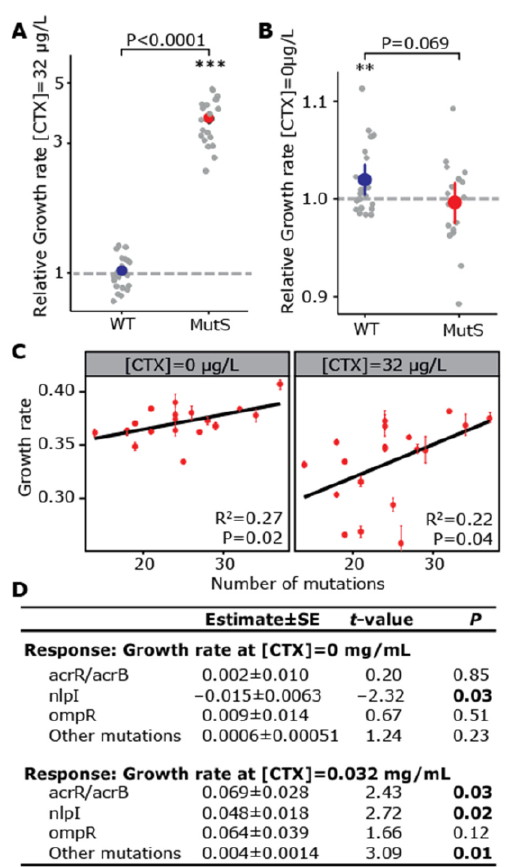
Figure 3. Fitness measurements of clones and fitness effects inferred for specific mutations in the presence and absence of cefotaxime. Growth rate in the absence ( A ) and presence of cefotaxime ( B ) of the sequenced clones relative to their respective ancestor (dashed line). Asterisks indicate significant increase (Mann–Whitney U test, **: p < 0.01, ***: p < 0.001). The p -values shown on top are from a Mann–Whitney U test comparing WT and MutS clones. ( C ) Linear regression analysis between the number of mutations in sequenced MutS clones and their relative growth rate in the absence and presence of cefotaxime. Error bars represent the standard error of the mean of three biological replicates. ( D ) Selection coefficient estimates and significance results of common resistance mutations, inferred using a general linear model of the growth rate in the absence and presence of cefotaxime as a linear function of the number of mutations in each category. p -values in bold are significant at p < 0.05